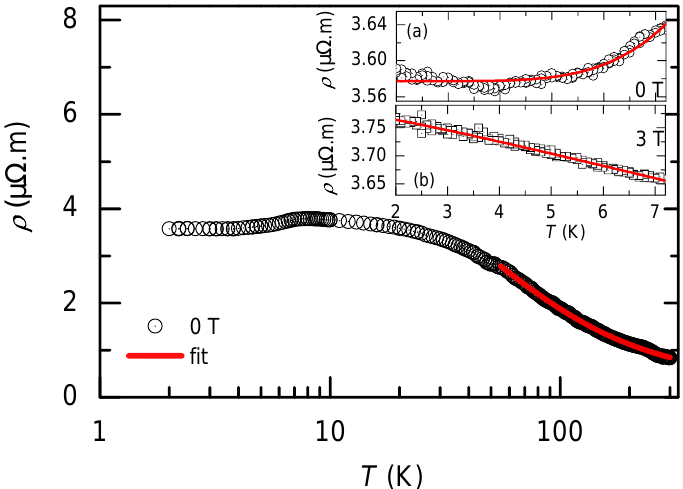
Figure 4. ( a ) The electrical resistivity ρ ( T ) of Sm 3 Co 4 Ge 13 in zero field is presented in the main panel. Magnetic phase transition at T N ≈ 6 K is seen as a broad feature. A curve-fit according to exponential expression for semi-conducting nature (Equation (2)) is shown as a solid line. The inset ( a ) shows the ρ ( T ) region below T N along with curve-fit assuming spin-waves (Equation (3)). The inset ( b ) shows the same fit for 3 T